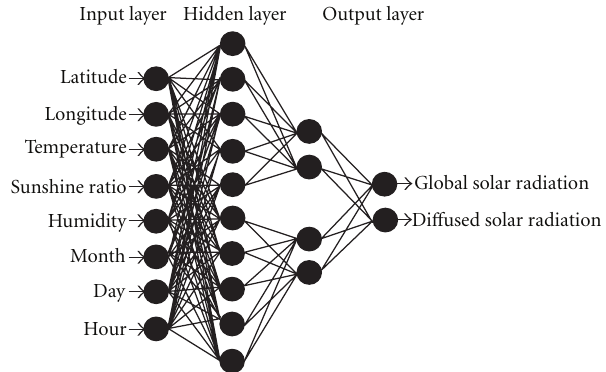
Figure 1: GRNN for solar radiation